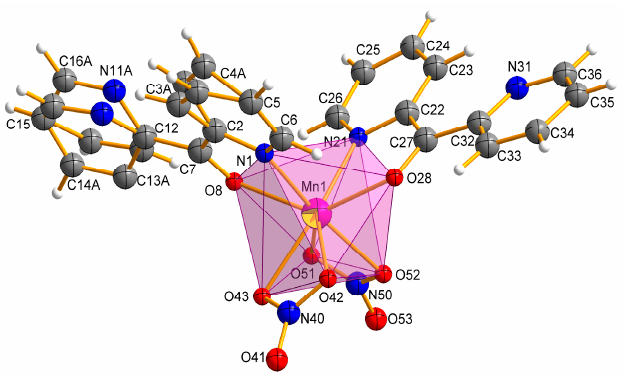
Figure 2. Molecular structure with the atom numbering scheme and coordination polyhedron of Mn-dipyCO-NO 3 .